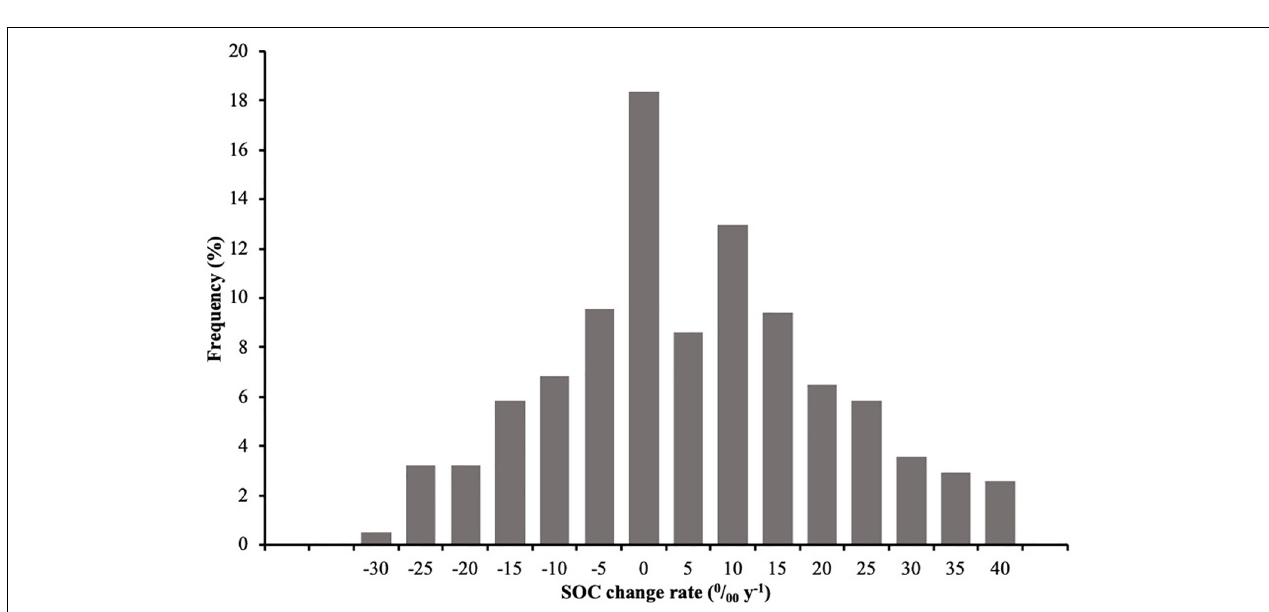
FIGURE 3 | Minimum detectable change of soil organic carbon (SOC) at farm scale, as a function of the number of fields. Black dots: calculated using Eq. (2) and the estimated variance of the difference between two consecutive analyses at farm scale; gray dots: calculated using Eq. (3) and the estimated variance of SOC content at farm scale.